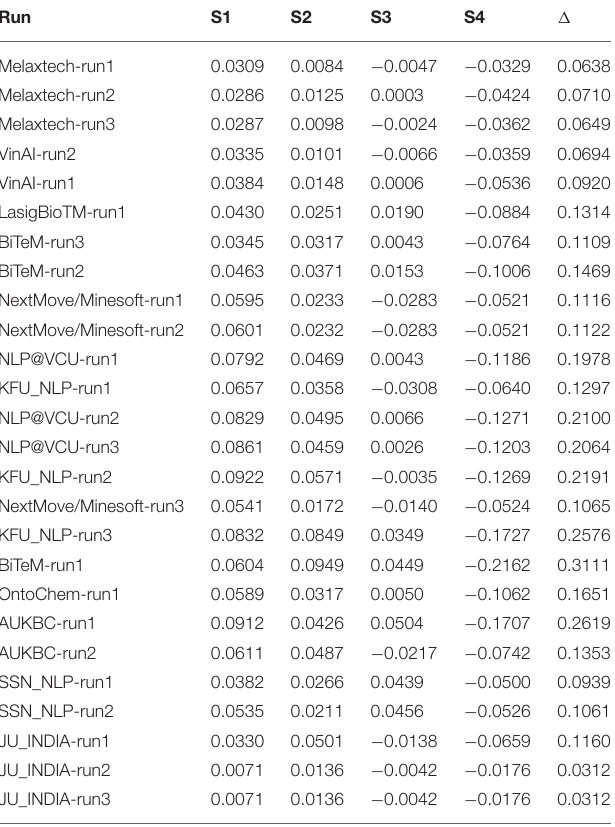
TABLE 14 | F 1 scores of all runs on S1 to